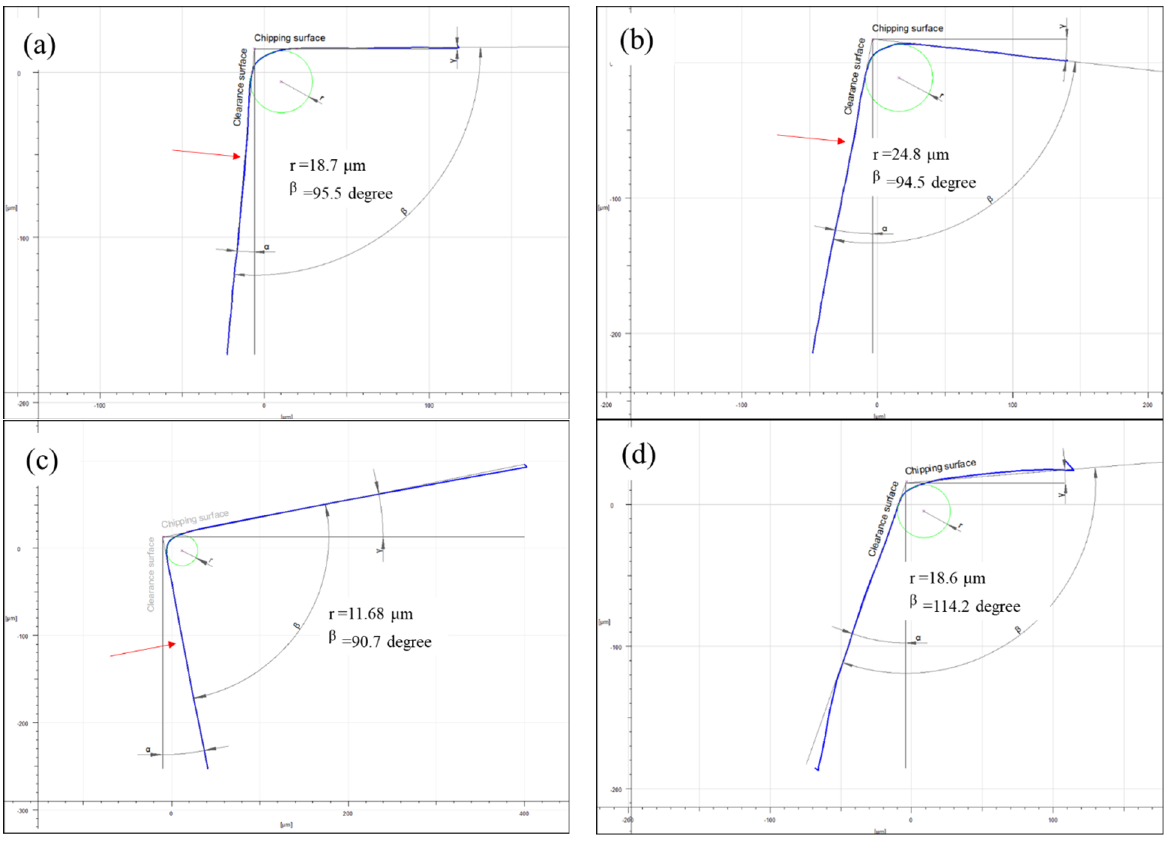
Figure 6. Sharpness of the worn cutting edges of different PCD inserts: ( a ) 002A, ( b ) 002E, ( c ) 302A, and ( d ) 302E.